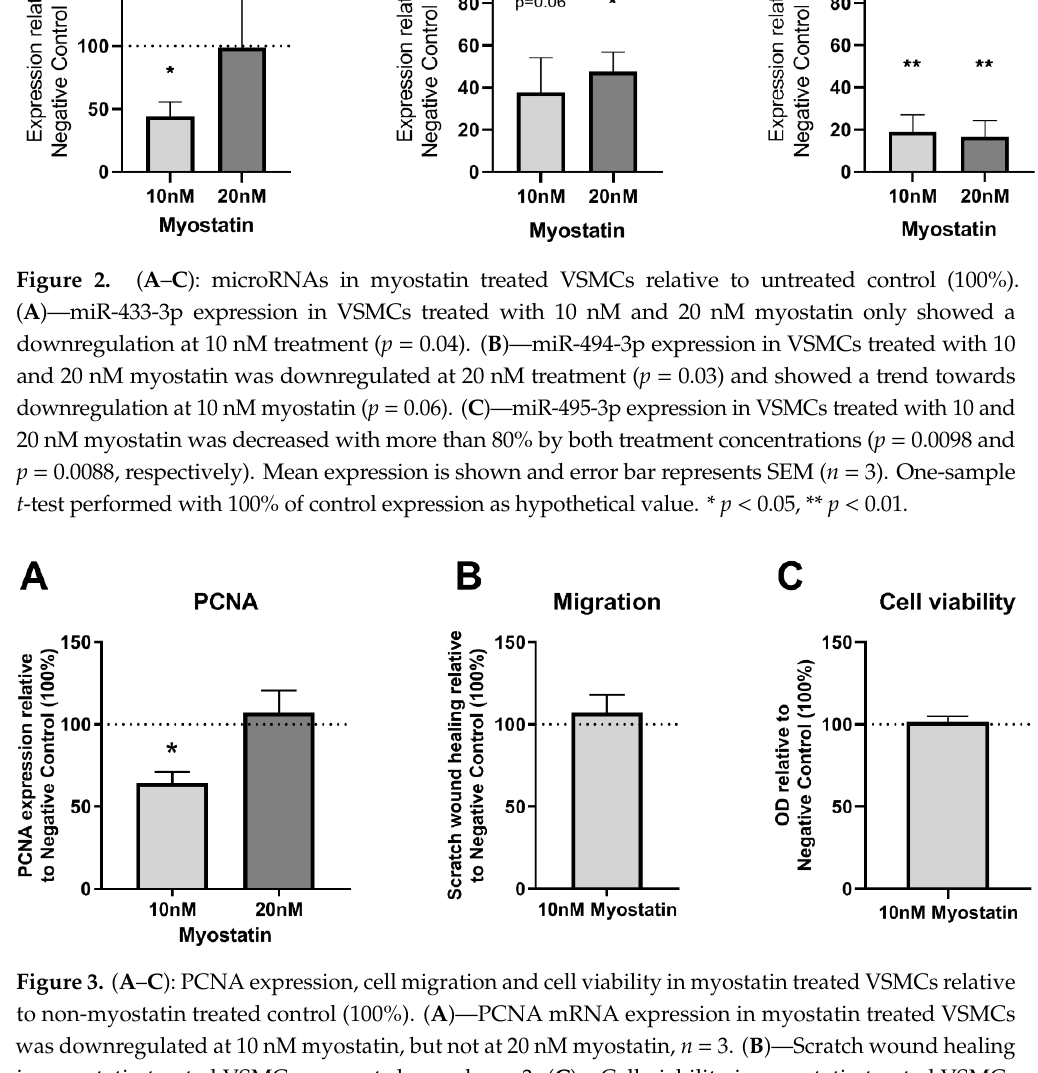
Figure 3. A-C: PCNA expression, cell migration and cell viability in myostatin treated VSMCs relative to non-myostatin treated control (100%). A —PCNA mRNA expression in myostatin treated VSMCs was downregulated at 10 nM myostatin, but not at 20 nM myostatin, n = 3. B —Scratch wound healing in myostatin treated VSMCs was not changed, n = 3. C —Cell viability in myostatin treated VSMCs remained unchanged, n = 4. Mean expression is shown and error bars represent SEMs. One-sample t- test performed with 100% of Negative Control expression as control group.